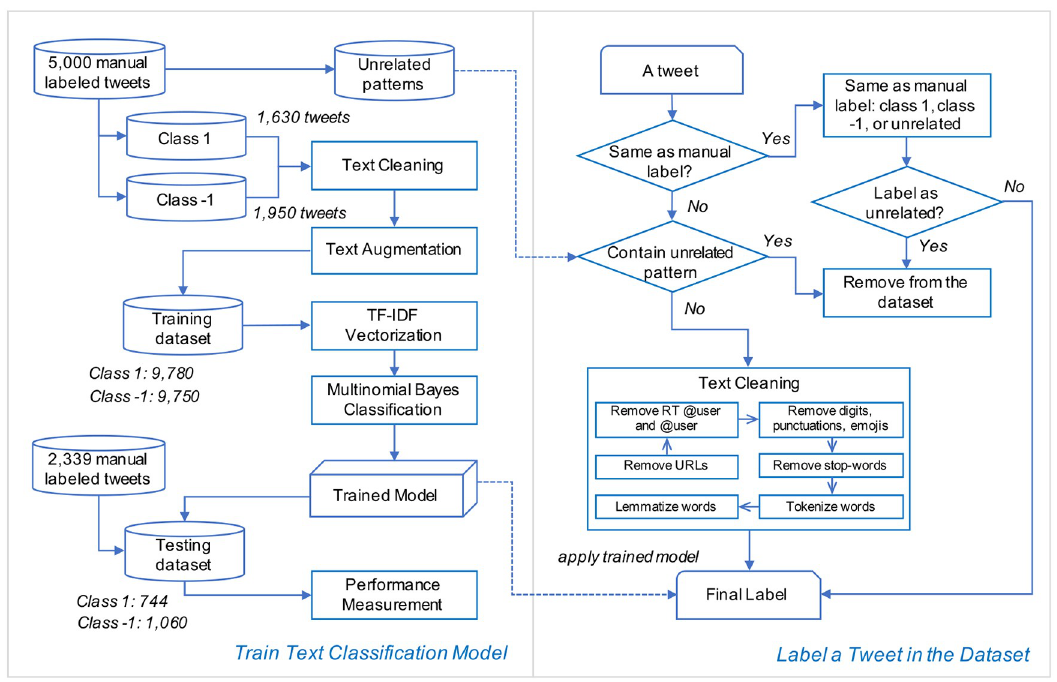
Fig 1. Model framework for the implementation of the proposed